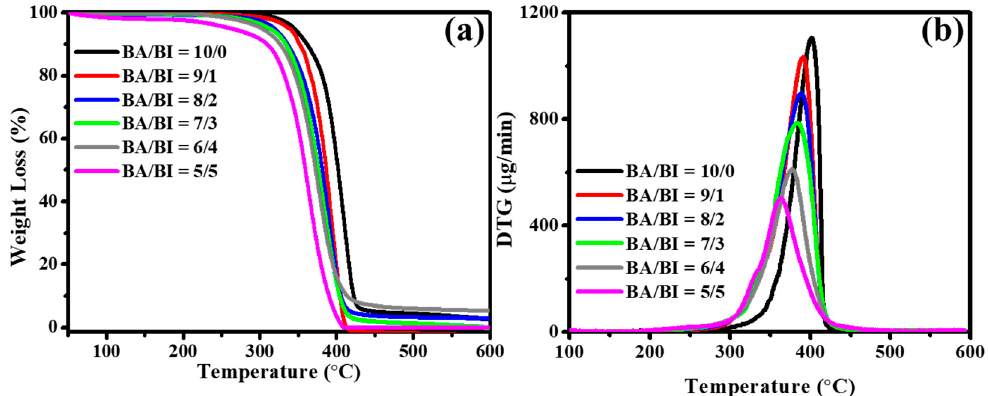
Figure 4. ( a ) Thermal gravimetric analyzer (TGA) and ( b ) derivative thermogravimetry (DTG) profiles of PBABI copolyesters with different BA/BI ratios.